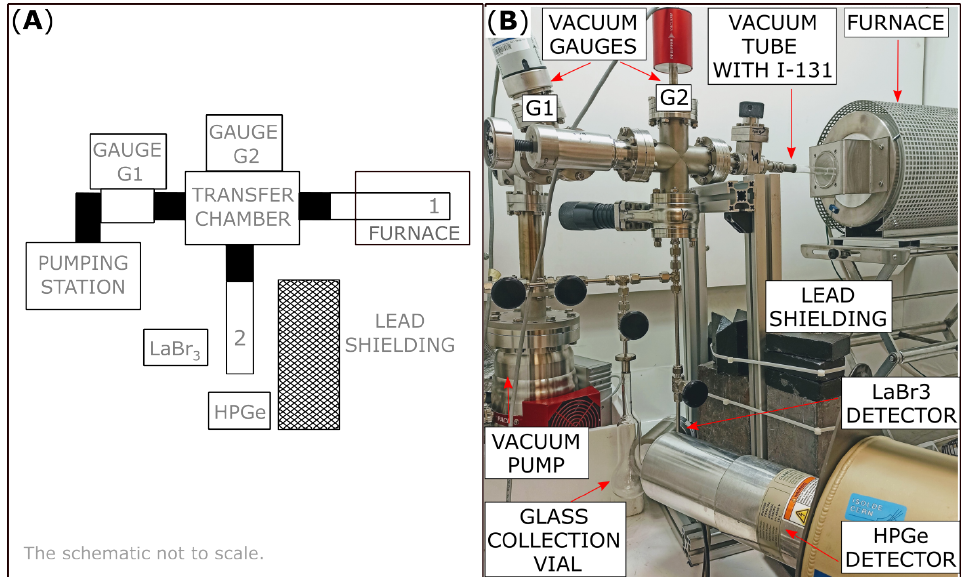
Figure 4. ( A ) A schematic of the extraction setup. The Na 131 I source (labelled 1) is in the glass annealing tube inside the furnace. The collection vial for 131m Xe is labelled 2. Black rectangles denote valves dividing the installation into separate cells. The full-range vacuum gauge (labelled G1) was mounted at the interface between the pumping station and the transfer chamber. The capacitance diaphragm vacuum gauge (labelled G2) was mounted to the transfer chamber ( B ) A photograph of the experimental installation for xenon extraction and